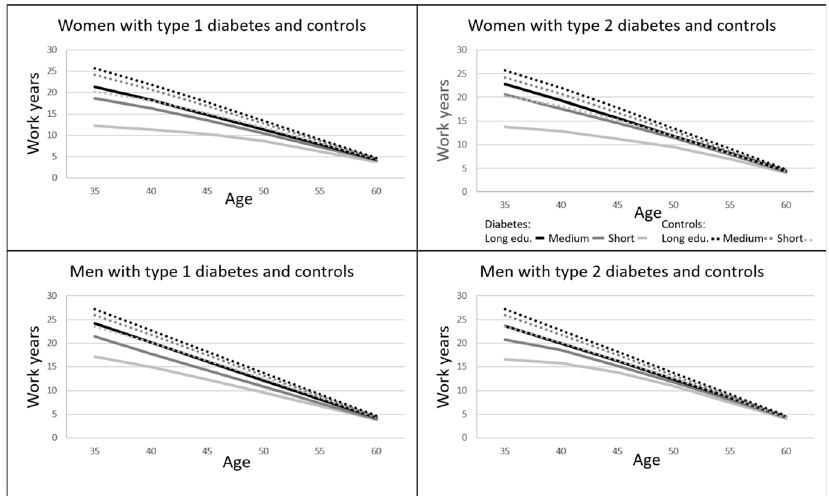
figure S1 (www.sjweh.fi/article/3972 ) and table 2b give an overview of the same estimates for participants living alone. The figures highlight the educational dif - ferences in